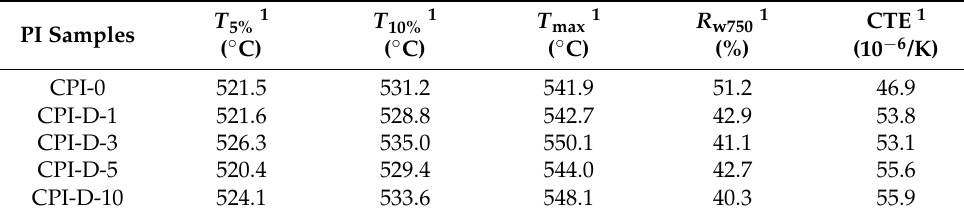
Table 6. Thermal properties of the CPI-0 film and CPI/791 nanocomposite films.